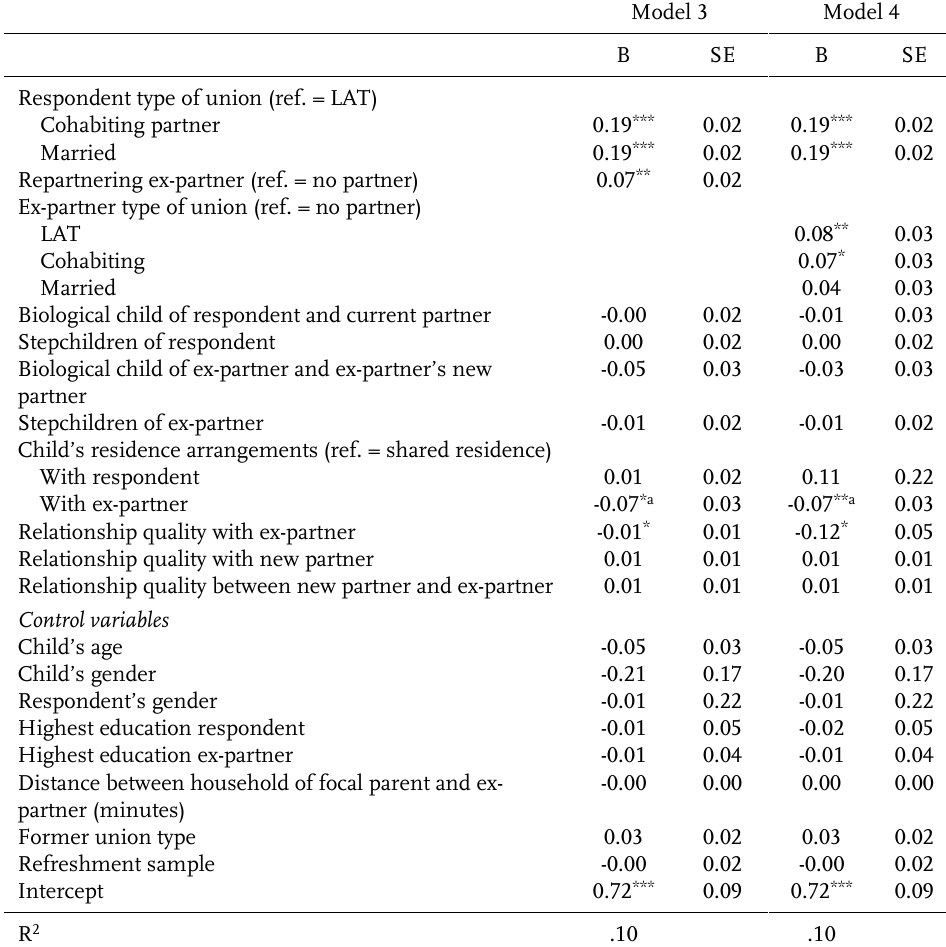
Table 3: Summary of linear probability models predicting the current partner’s attendance at the child’s last birthday